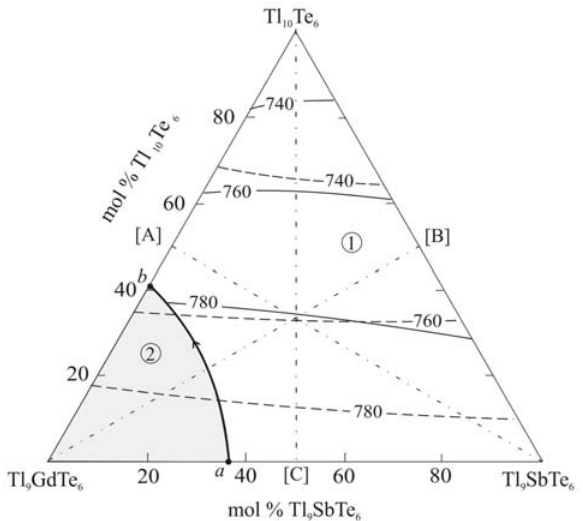
Fig.4. Projections of the liquidus and solidus (dashed lines) surfaces of the Tl Te -Tl GdTe -Tl SbTe system. Dash-dot lines show the in- 5 3 9 6 9 6 vestigated sections. Primary crystallization phases: 1- δ ; 2-X phase.